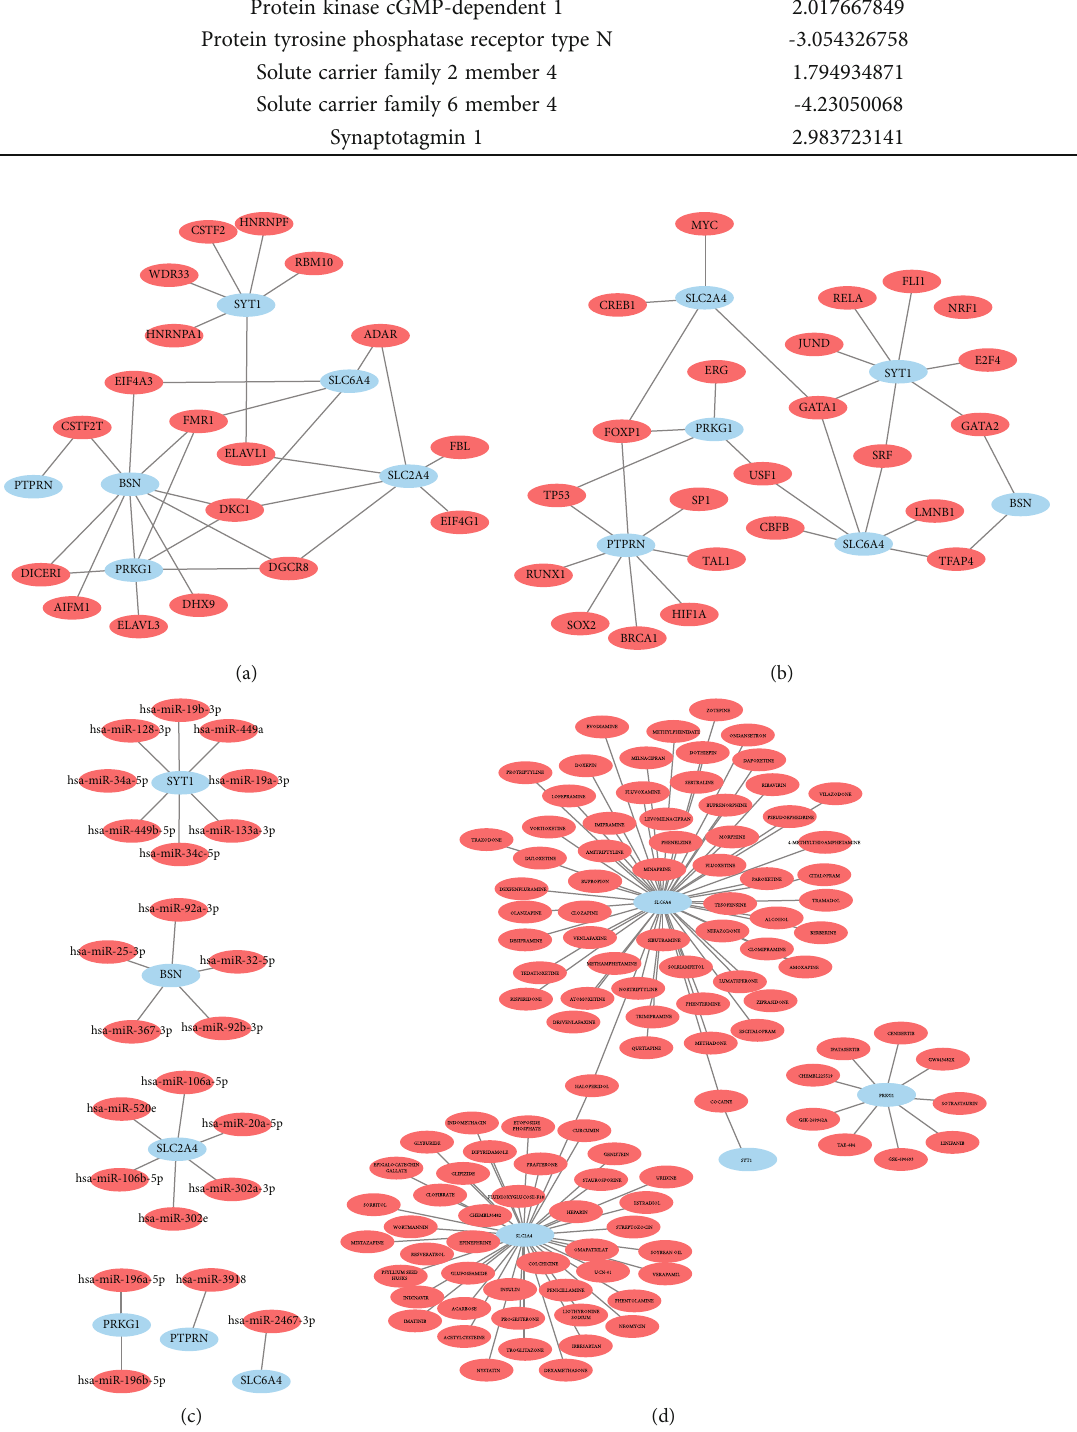
Figure 5: Construction of hub gene-RBP/TF/miRNA/drug network. (a) Construction of hub gene-RBP network. (b) Construction of hub gene-TF network. (c) Construction of hub gene-miRNA network. (d) Construction of hub gene-drug